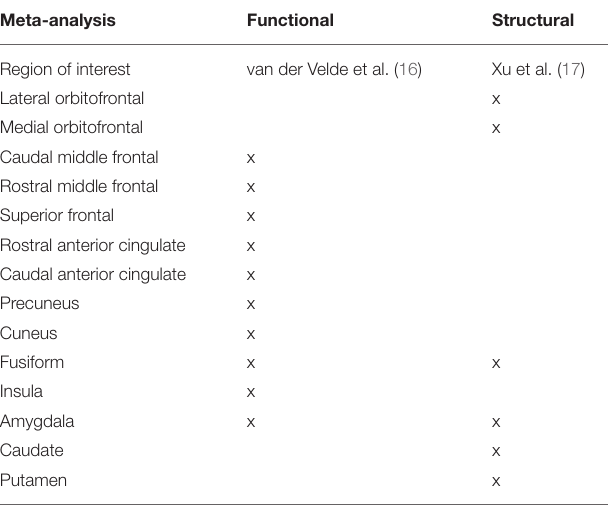
TABLE 1 | Brain regions involved in emotional awareness across